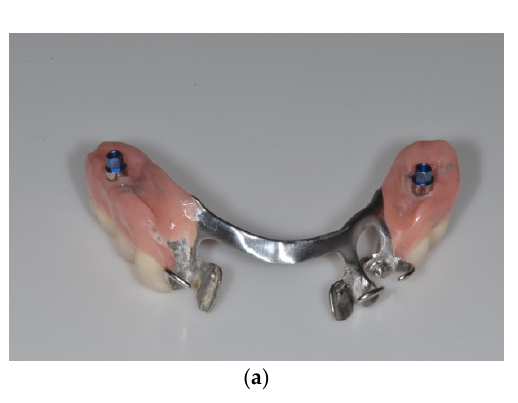
Figure 2. ( a ) Extraoral view of the converted prosthesis with dome abutments in place; ( b ) intraoral view with dome abutments mounted on the implants.